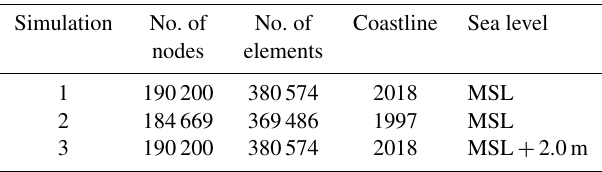
Table 1. Summary of the different meshes and scenarios simulated in the